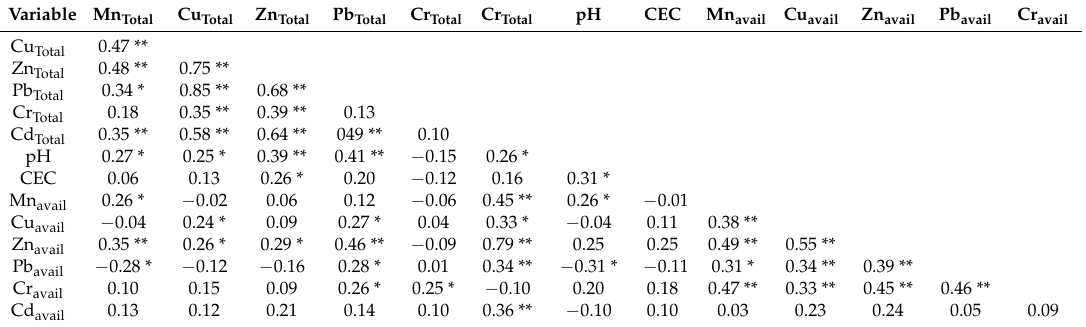
Table 5. Spearman’s correlations between heavy metals in soil.